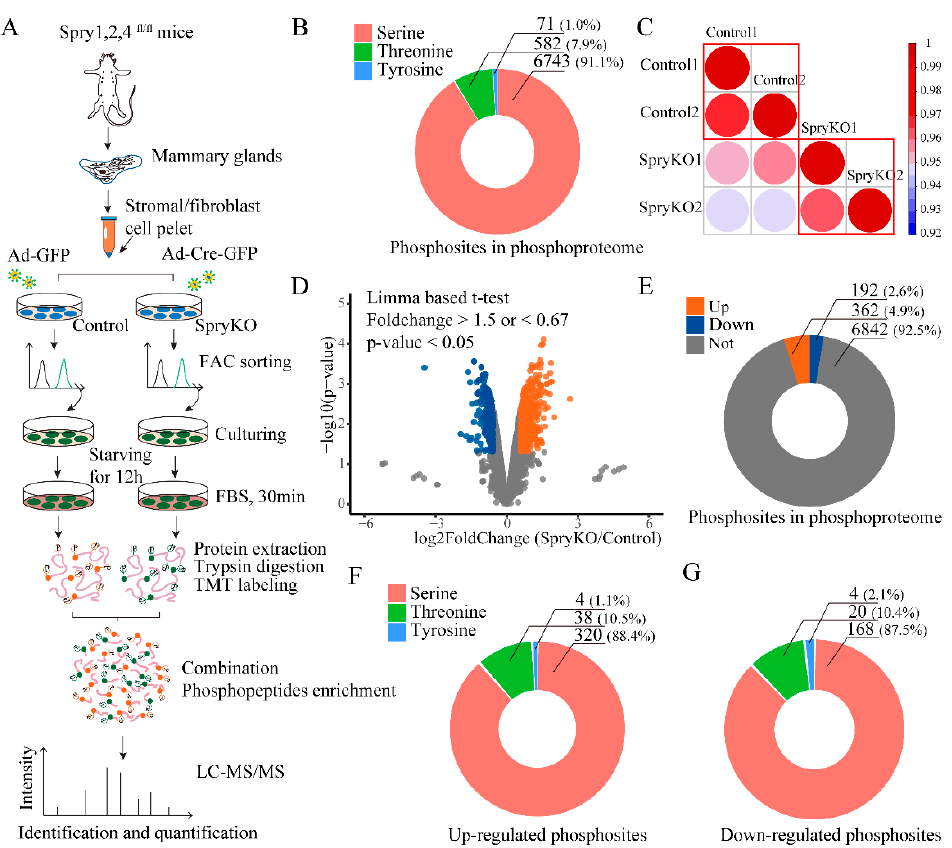
Figure 1. Overview of the analysis of SPRY-induced phosphoproteome in SpryKO mouse mammary stromal fibroblasts. ( A ) Schematic of phosphoproteome analysis workflow for the study of phosphorylation induced by a SPRY deficiency in mammary stromal fibroblasts. Two biological replicates were performed in the control and SpryKO groups, respectively; ( B ) Distribution of serine, threonine and tyrosine phosphorylation residuals in total quantified phosphosites with high localization probability (>0.75). Numbers and percentages are as shown in the ring plot; ( C ) The Pearson correlation coefficient between the duplicate mass spectrometry results in control and SpryKO mammary stromal fibroblasts; ( D ) Volcano plot of differently-regulated phosphosites by the SPRY deletion in mammary stromal fibroblasts. Limma-based t -test was used to determine the statistical significance in the analysis. Downregulated sites: Blue points, p -value < 0.05, fold change < 0.67; up-regulated sites: Orange points, p -value < 0.05, fold change > 1.5; ( E ) Phosphorylation residuals distribution of the differently regulated phosphosites. Numbers and percentages are as shown in the ring plot; ( F ) Phosphorylation residuals distribution of the up-regulated phosphosites. Numbers and percentages are as shown in the ring plot; ( G ) Phosphorylation residuals distribution of the down-regulated phosphosites. Numbers and percentages are shown in the ring plot.